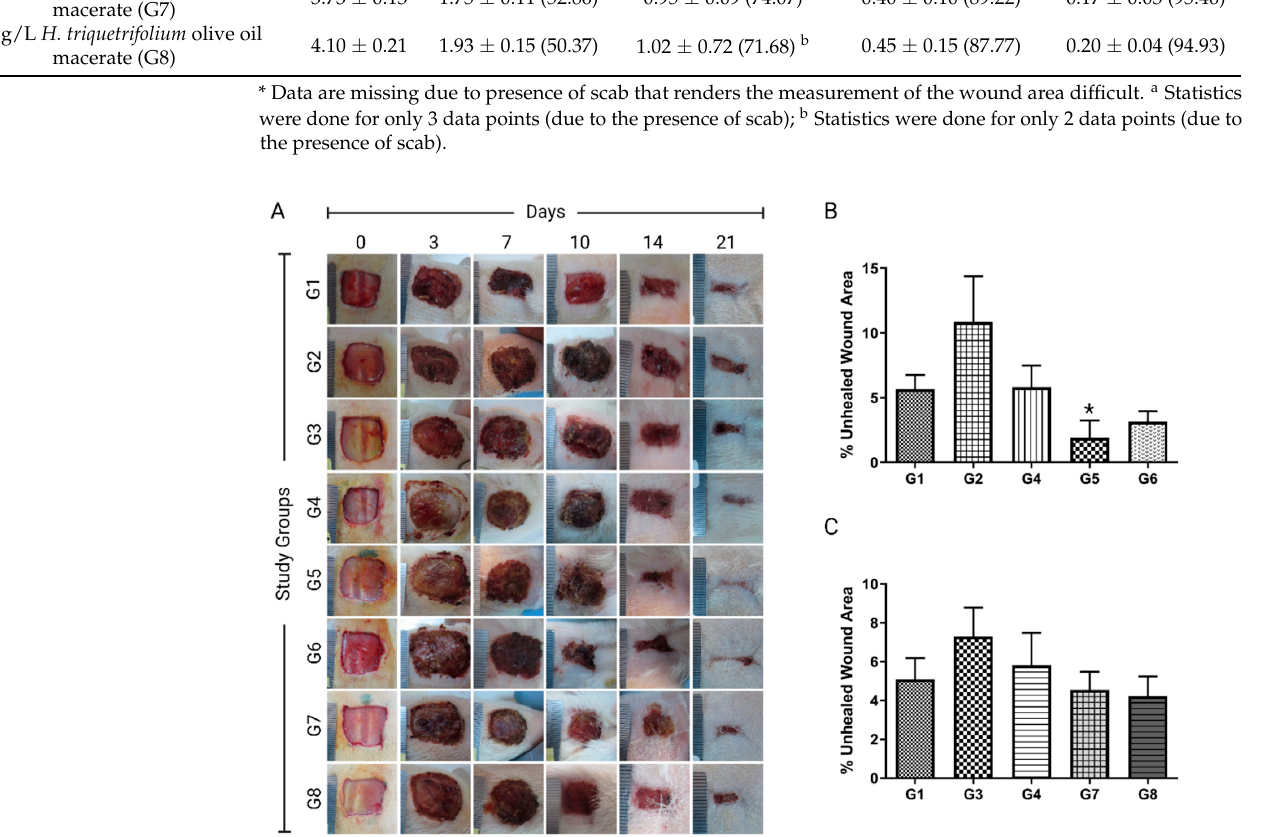
Figure 2. Photographs of wounds and their respective unhealed wound area percentage by different treatment groups ( A ). Negative control (G1), petroleum jelly (G2), olive oil (G3), MEBO (G4), 5% H. triquetrifolium ointment (G5) , 10% H. triquetrifolium ointment (G6), 100 mg/L H. triquetrifolium olive oil macerate (G7), and 200 mg/L H. triquetrifolium olive oil macerate (G8). Wound photographs scales are represented in millimeters. Unhealed wound area across test groups ( B , C ). * Denotes for statistical signi fi cance ( p ≤ 0.05) compared to the corresponding vehicle. Table 1. E ff ects of the investigated formulations on excision wound model.